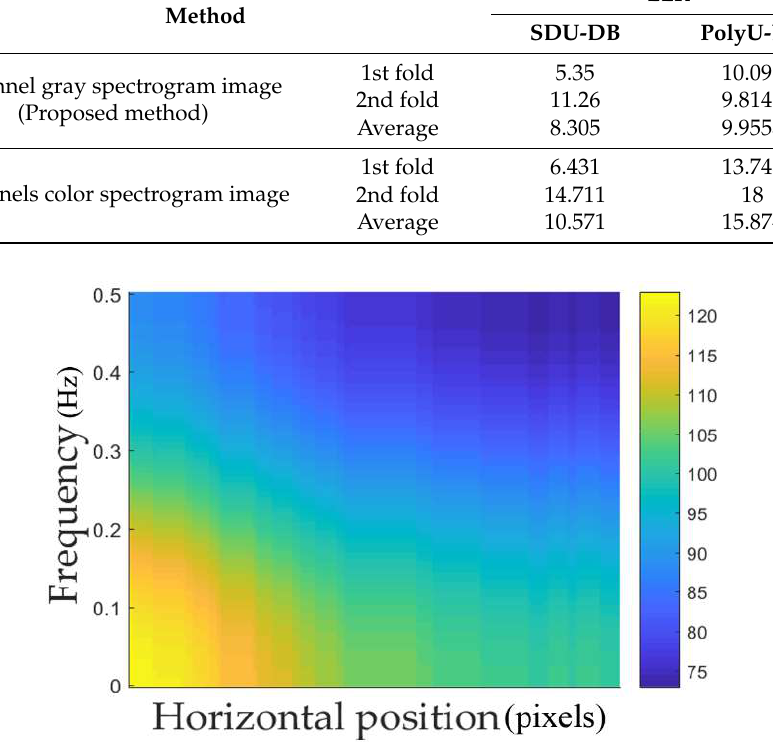
Figure 11. Example of 3 channel color spectrogram image of Figure 4a,b.